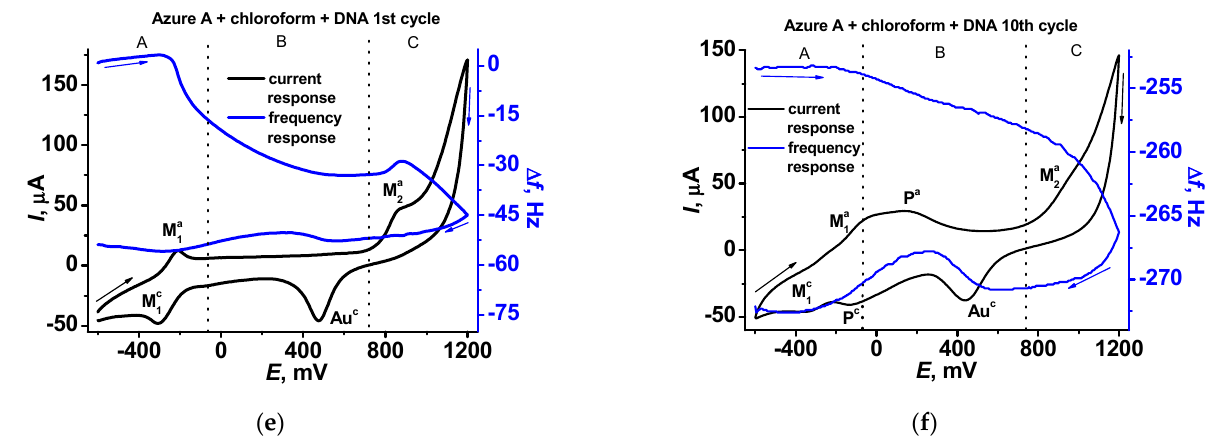
Figure 7. Cyclic voltammograms (black) and sensograms (blue) recorded on the QCM chip in 0.1 M phosphate buffer containing 0.1 M NaNO 3 , pH = 7.0 ( a , b ), in the presence of chloroform ( c , d ), and in the presence of chloroform and 0.2 mg/mL DNA ( e , f ).